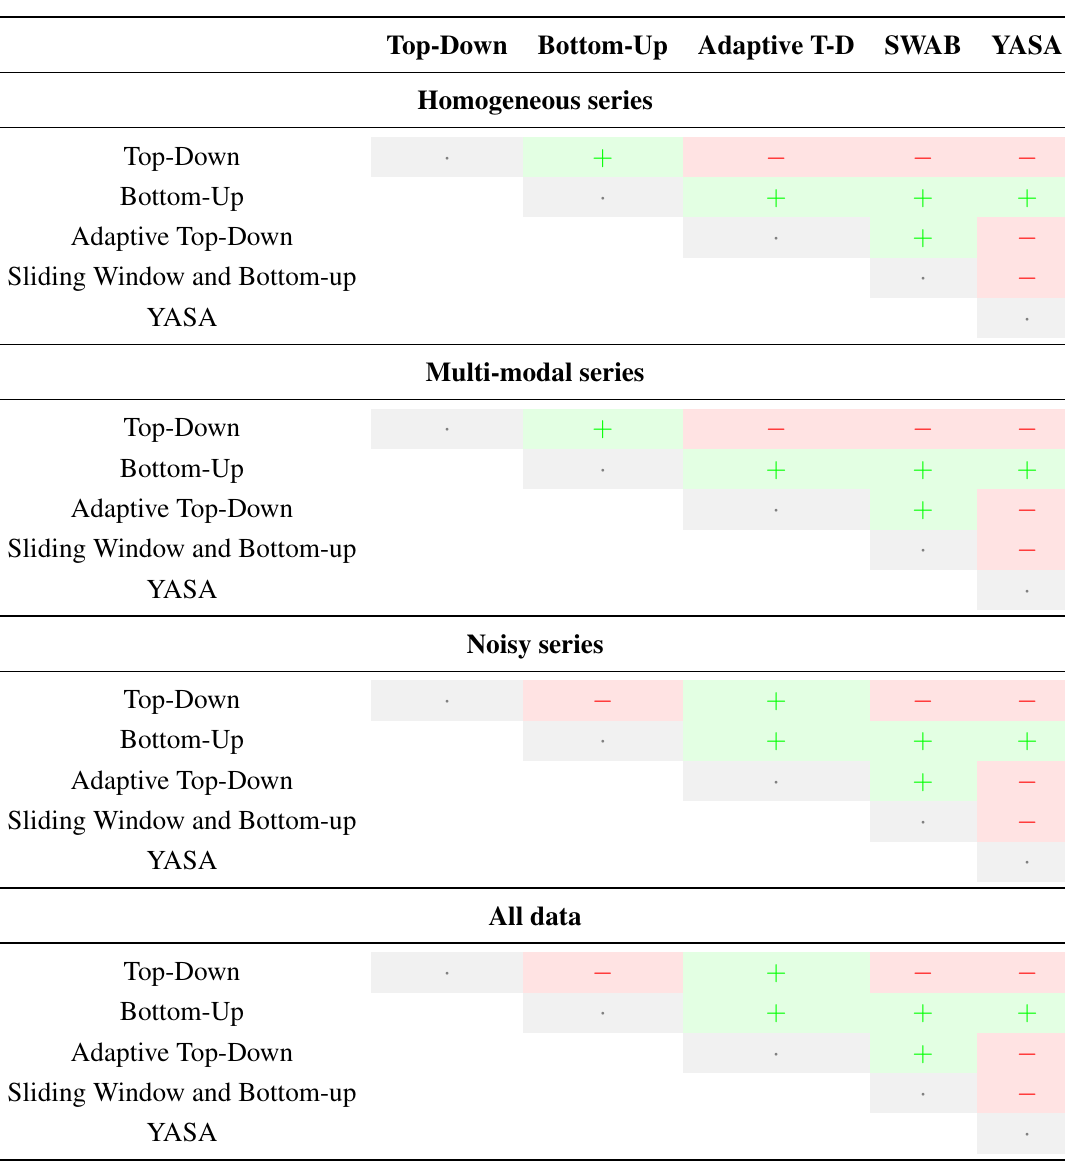
Table 1. Results of the statistical hypothesis tests on segmentation errors. Cells marked in green ( + ) are cases where a statistically-significant difference was observed. Red cells ( − ) denote cases where the results of both algorithms were statistically